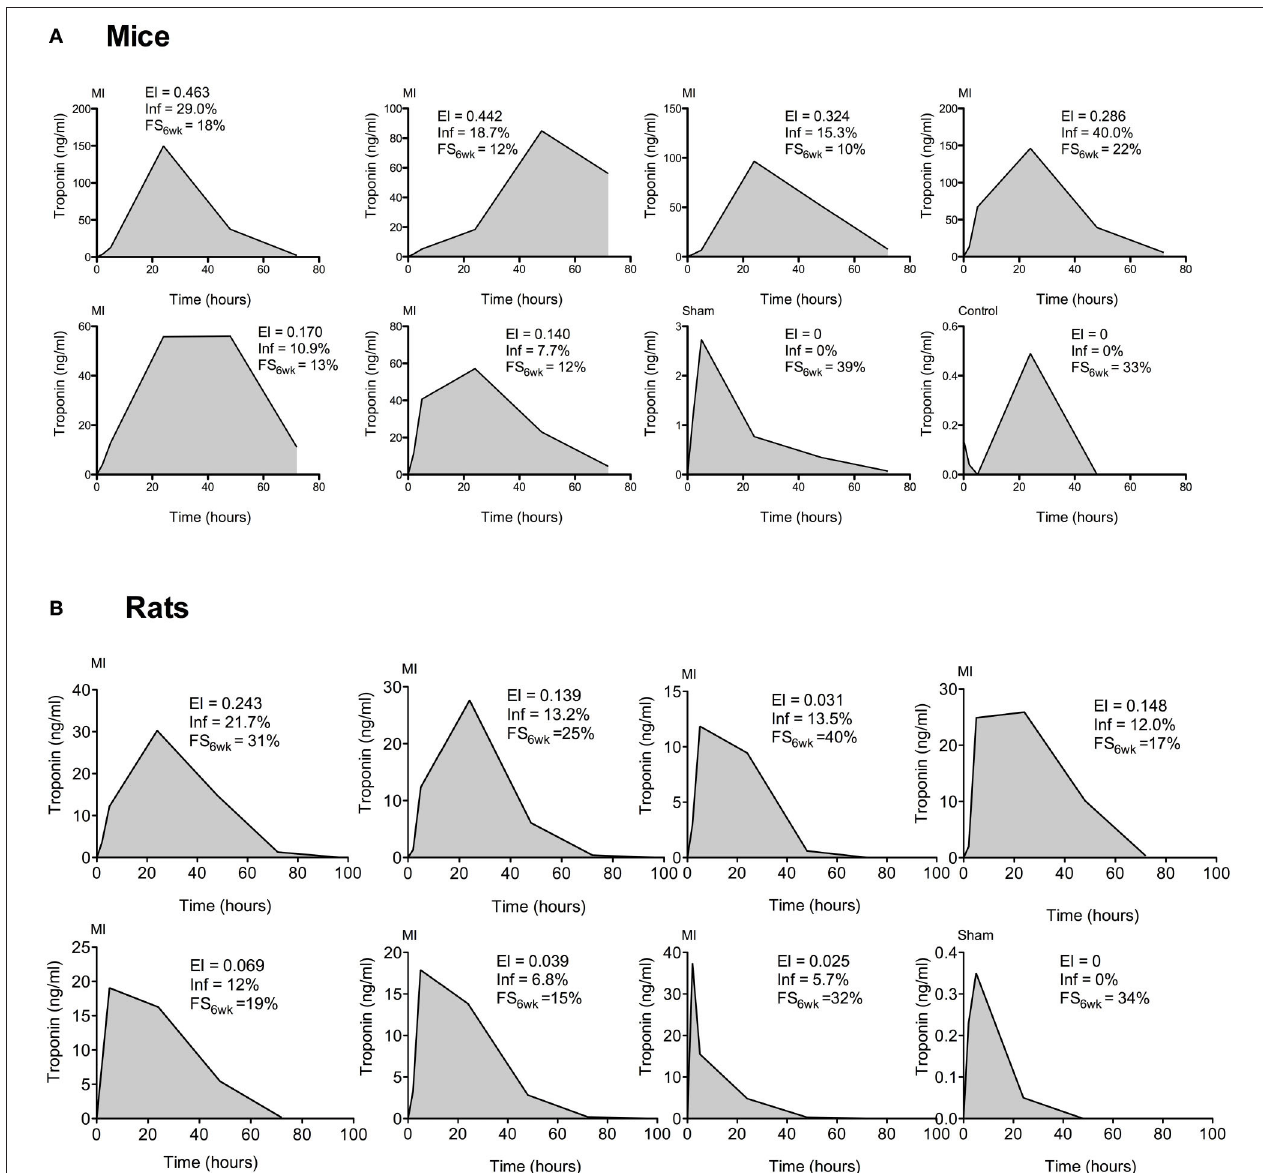
FIGURE 3 | Representative individual kinetics of plasma cTnI for mice (A) and rats (B): cTnI levels were measured at 2, 5, 24, 48, and 72h post LAD ligation (MI) or in sham-operated animals (sham). Y-axis scales have been individually optimized for each graph. The peak and the area under the plasma drug concentration-time curve (AUC) are proportional to the myocardial damage, which are expressed as the expansion index (EI) and % of infarcted left ventricle (Inf). The FS recorded 6 weeks post-MI is also